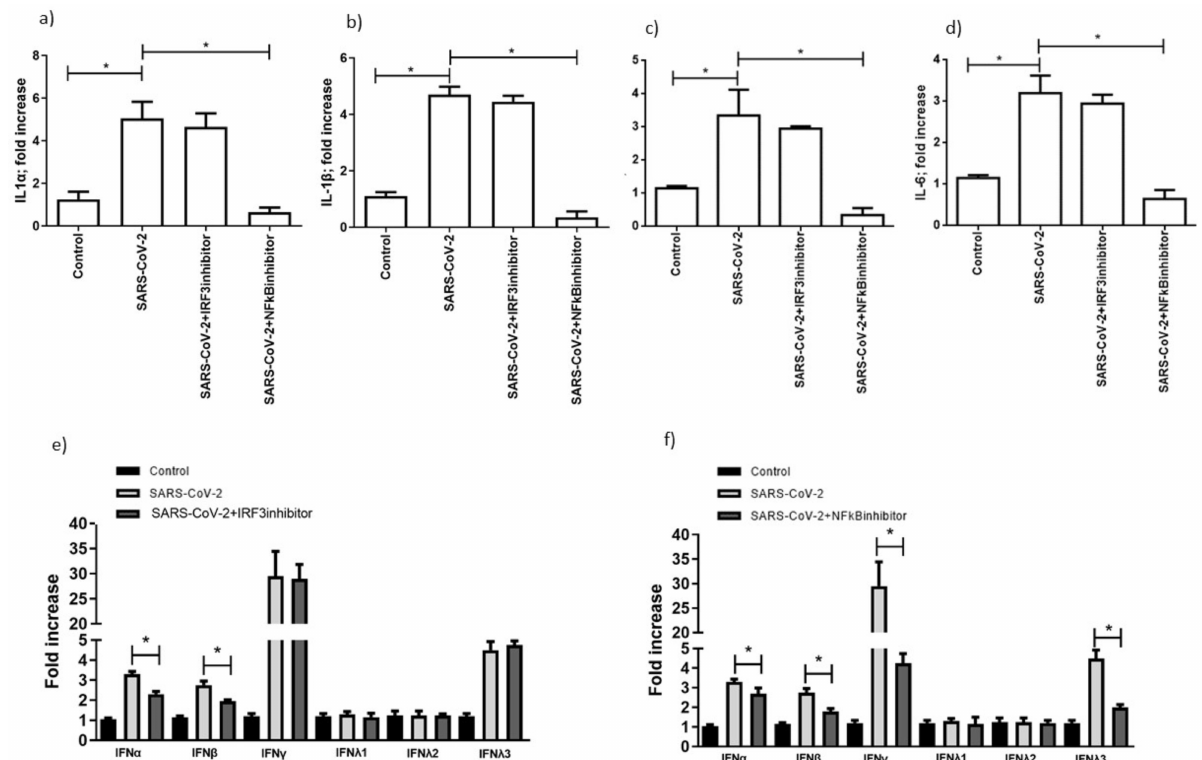
Figure 5. Levels of expression of cytokines ( a ) IL-1 α , ( b ) IL-1 β , ( c ) IL-4, ( d ) IL-6, ( e ), ( f ) IFN- α , IFN- β , IFN- γ , IFN- λ 1, IFN- λ 2, IFN- λ 3 are reported, in the presence or absence of NF κ B or IRF3 inhibitors. The levels of IFNs in the presence of IRF3 inhibitor were evaluated 24 h post-infection. Data correspond to the mean +/ − standard deviation. * p value < 0.05, calculated with Student’s t